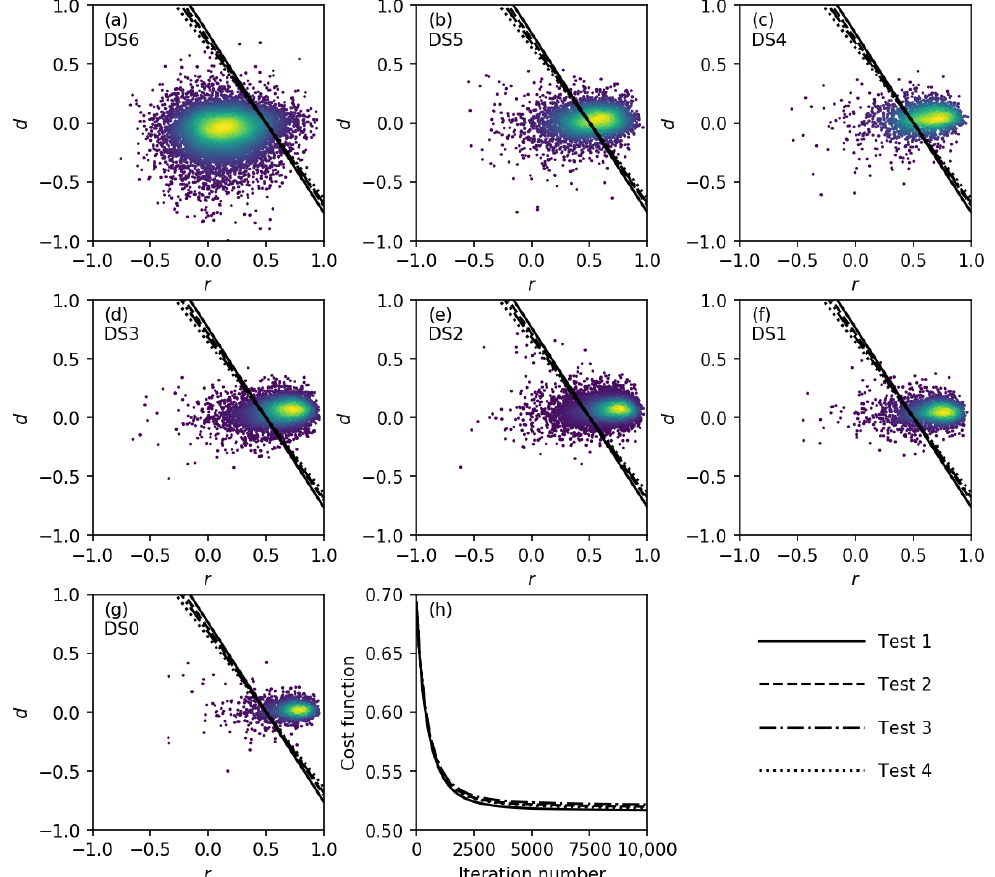
Figure 4. Discriminant functions obtained using the fragility function of Koshimura et al. [26]. ( a – g ) Scatter plots of the bi-dimensional dataset separated by damage state (DS), together with the obtained discriminant functions; ( h ) Variations of the cost function ( J ( θθθ ) ) throughout the iterative gradient descent